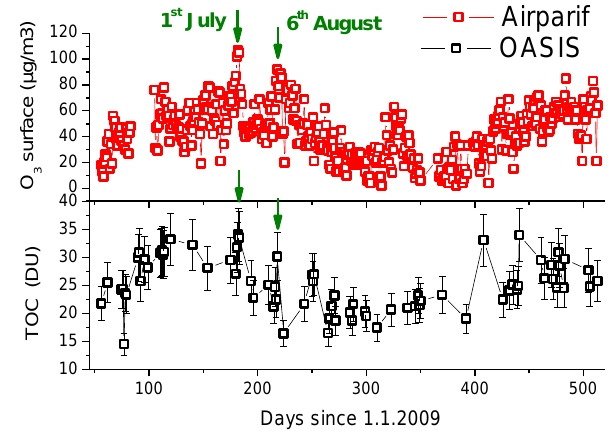
Fig. 5. Times series of tropospheric ozone (tropospheric ozone columns, TOC) from OASIS (black symbols) and surface concen- Figure 5 : Times series of tropospheric ozone (tropospheric ozone columns, TOC) from 350 trations from in-situ measurements of the AirParif network (red OASIS (black symbols) and surface concentrations from in-situ measurements of the AirParif 351 network (red symbols). 352